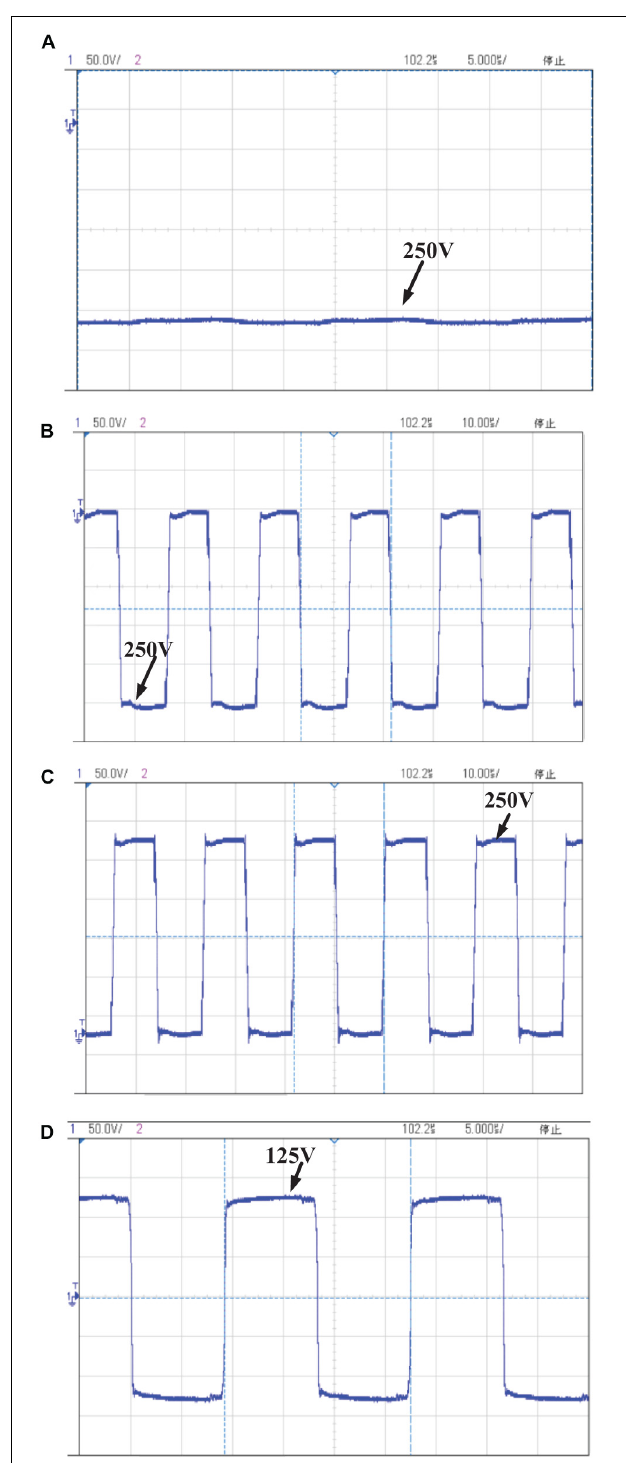
FIGURE 10 | Experimental waveform of each device when the circuit output is 1,000 V of Figure 2A . (A) Voltage waveform of capacitor C 2 ( Figure 4 ) at 1,000 V output. (B) Voltage waveform of diode D 1 ( Figure 4 ) at 1,000 V output. (C) Voltage waveform of diode D 2 ( Figure 4 ) at 1,000 V output. (D) Voltage waveform of transformer secondary windings ( Figure 4 ) at 1,000 V